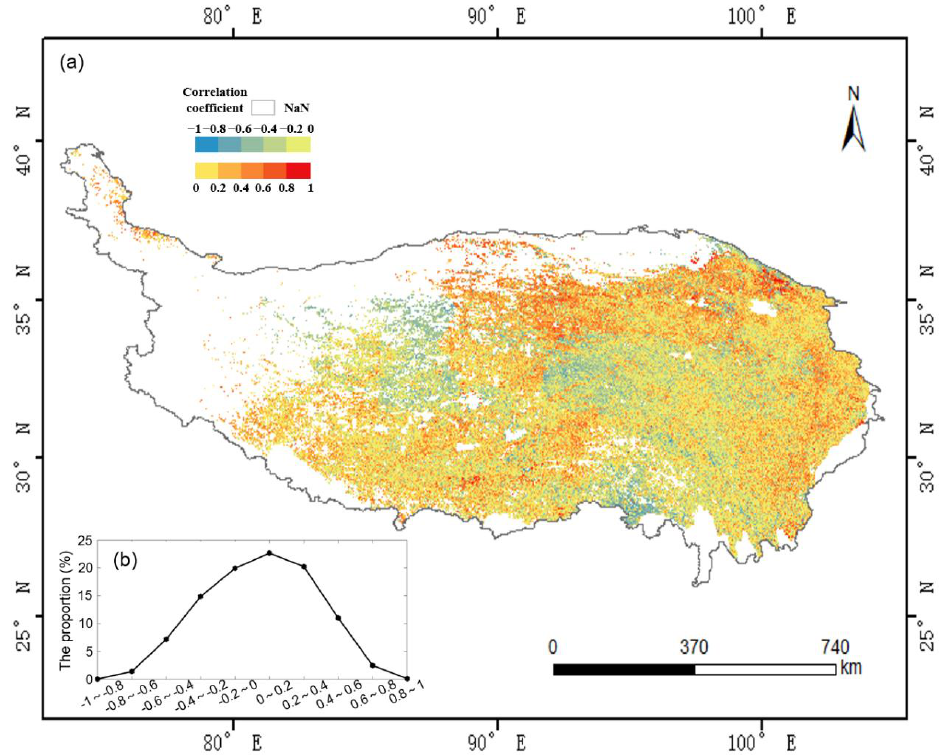
Figure 12. Correlation analysis of vegetation NPP with human activities ( a ). NaN represents no change in NPP or human activities data for the region from 2001 to 2017 (the denominator in the correlation coefficient equation (Equation (2) in Section 2.2.2) was zero). The proportional distribution of correlation coefficient between NPP and human activities ( b ). Remote Sens. 2021 , 13 , 1566